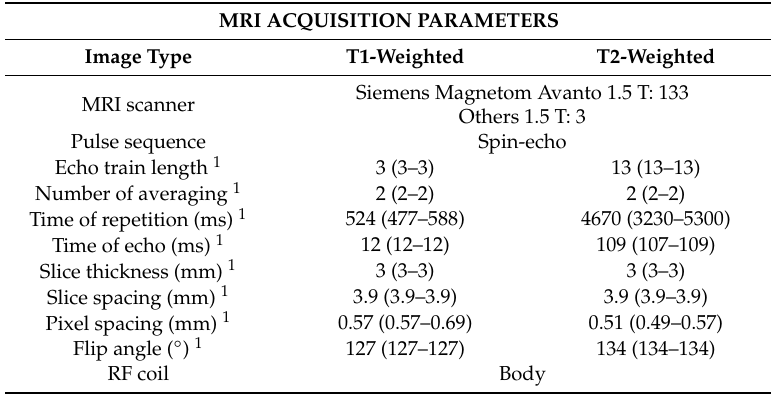
Table 2. Acquisition parameters for the di ff erent sequences of magnetic resonance imaging (MRI). Parameters are shown for both T1-weighted and T2-weighted